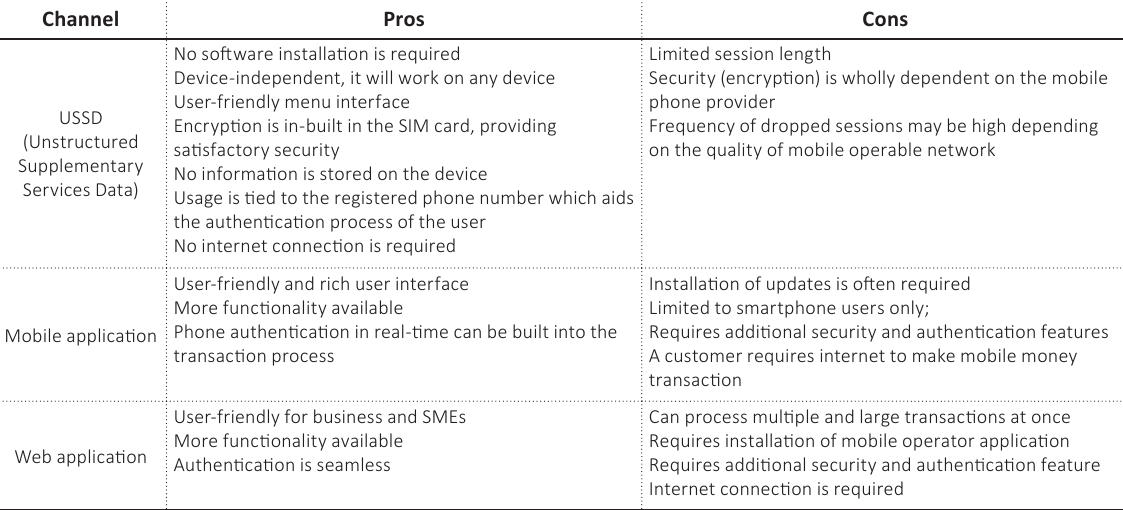
Table 1. Mobile money channel evaluation